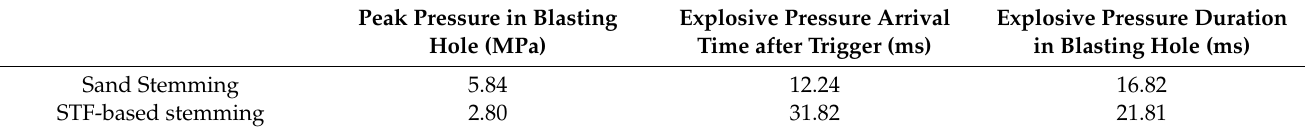
Table 2. Result of the explosion pressure measurement in blast